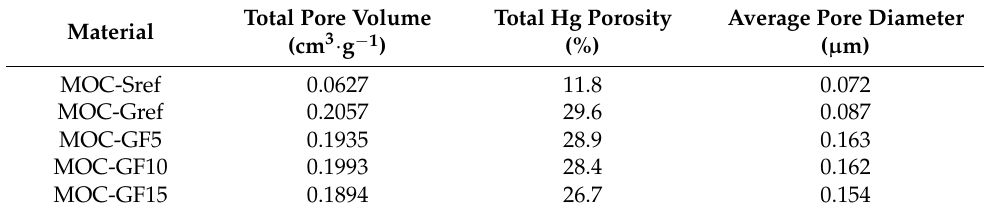
Table 5. Microstructural parameters measured by MIP.